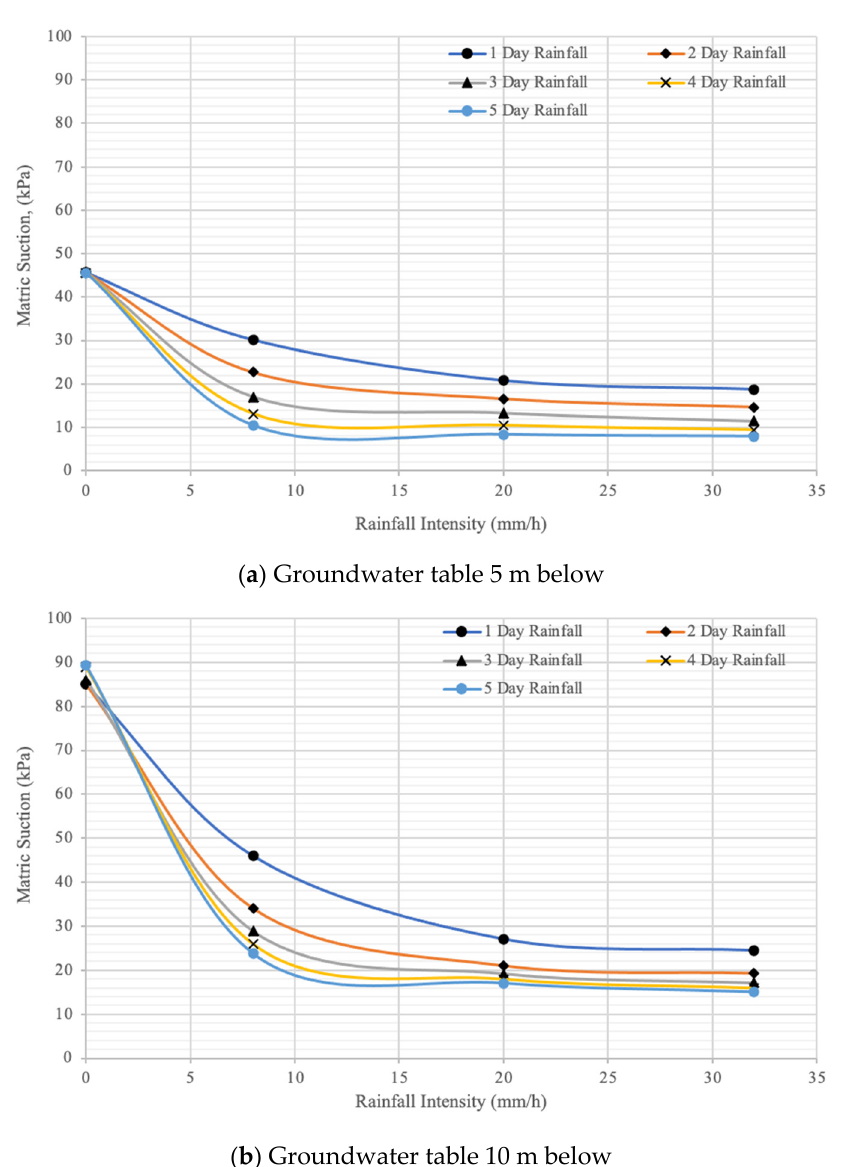
Figure 6. Effects of rainfall intensity on the matric suction (500 kPa applied loading).